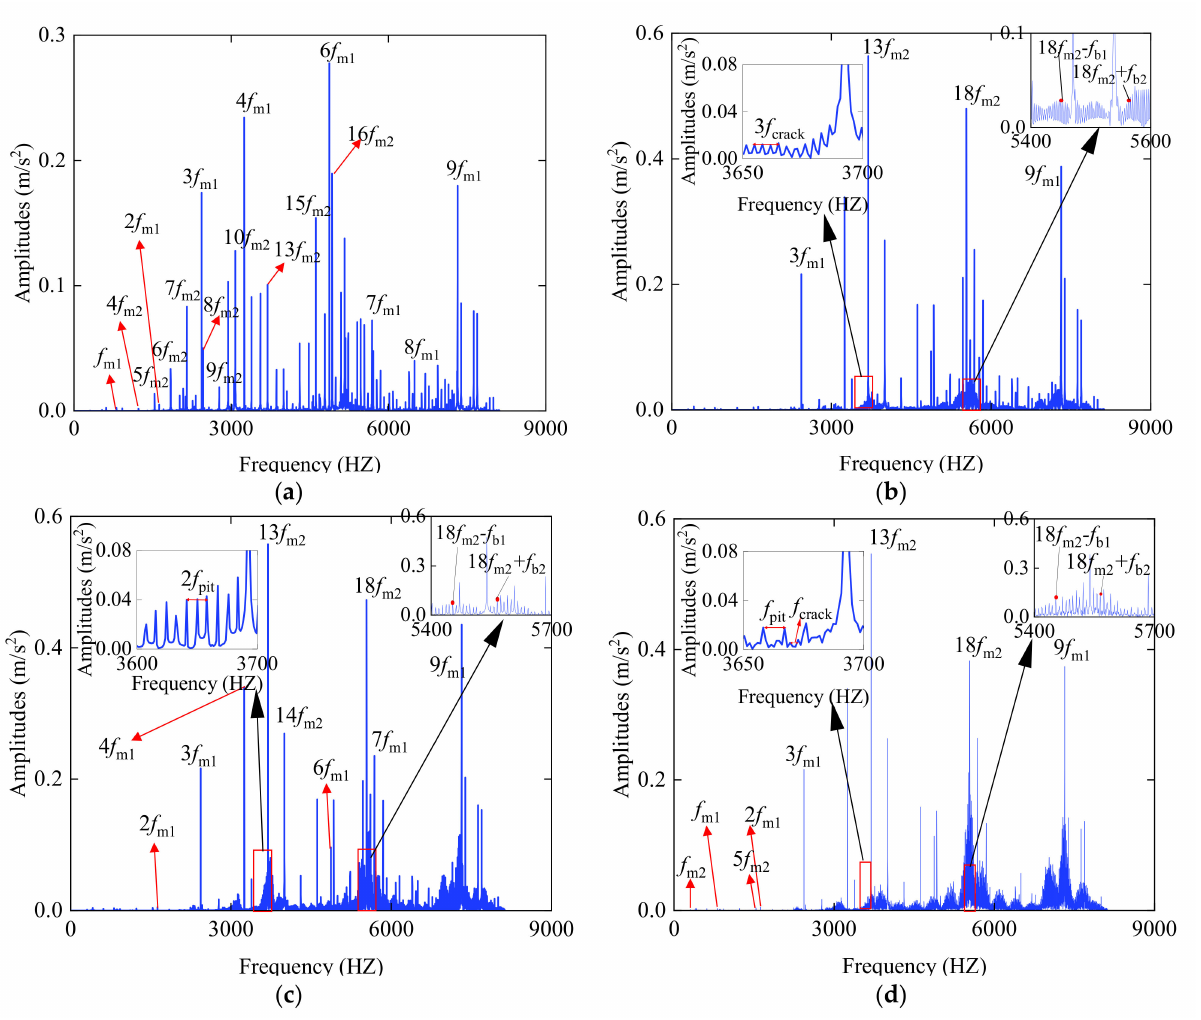
Figure 23. Simulated acceleration signals in frequency domain of gear systems with different faults: ( a ) Normal gear system; ( b ) Gear system with cracks; ( c ) Gear system with pitting; ( d ) Gear system with cracks and pitting.